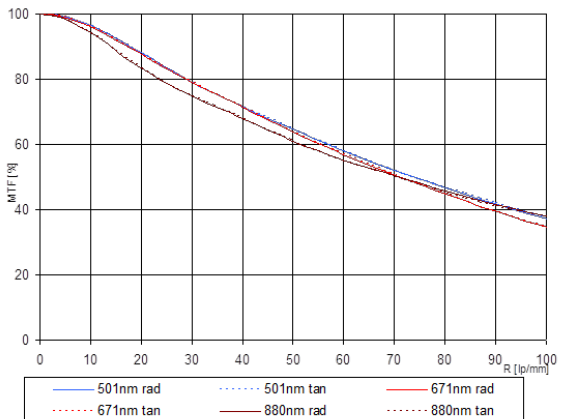
Figure 4. Spectral on-axis MTFs of the Flektogon 2.8/20